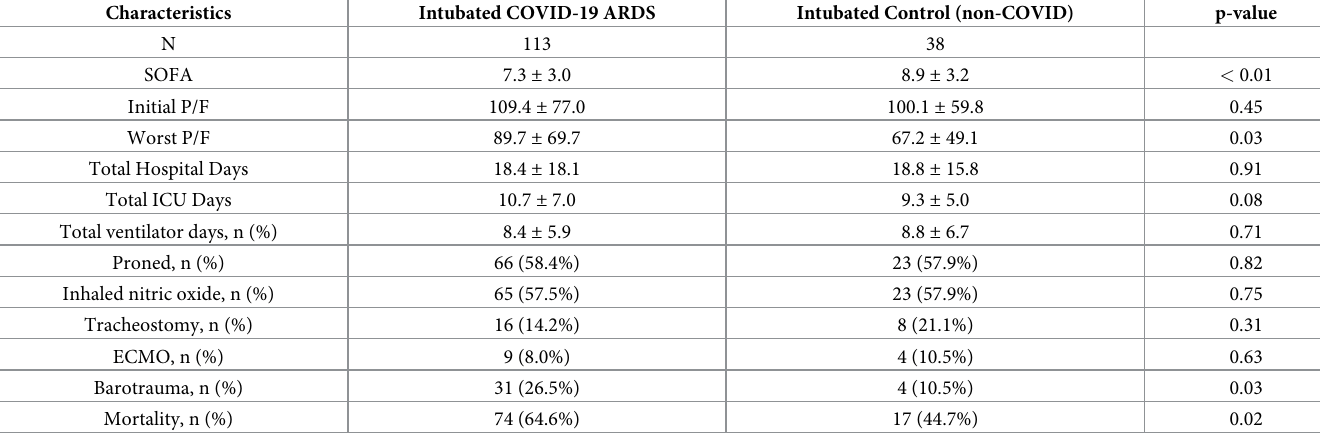
Table 2. Characteristics and outcomes of COVID-19 patients requiring invasive mechanical ventilation vs intubated non-COVID-19. Characteristics